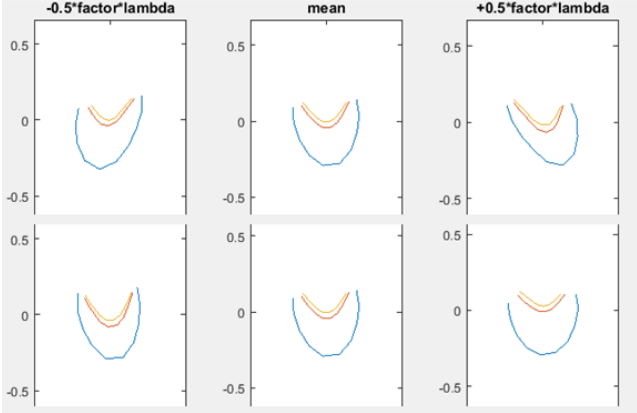
Figure 6: Example of 2 different modes with their mean in the central column, and adjacent, their respective variations